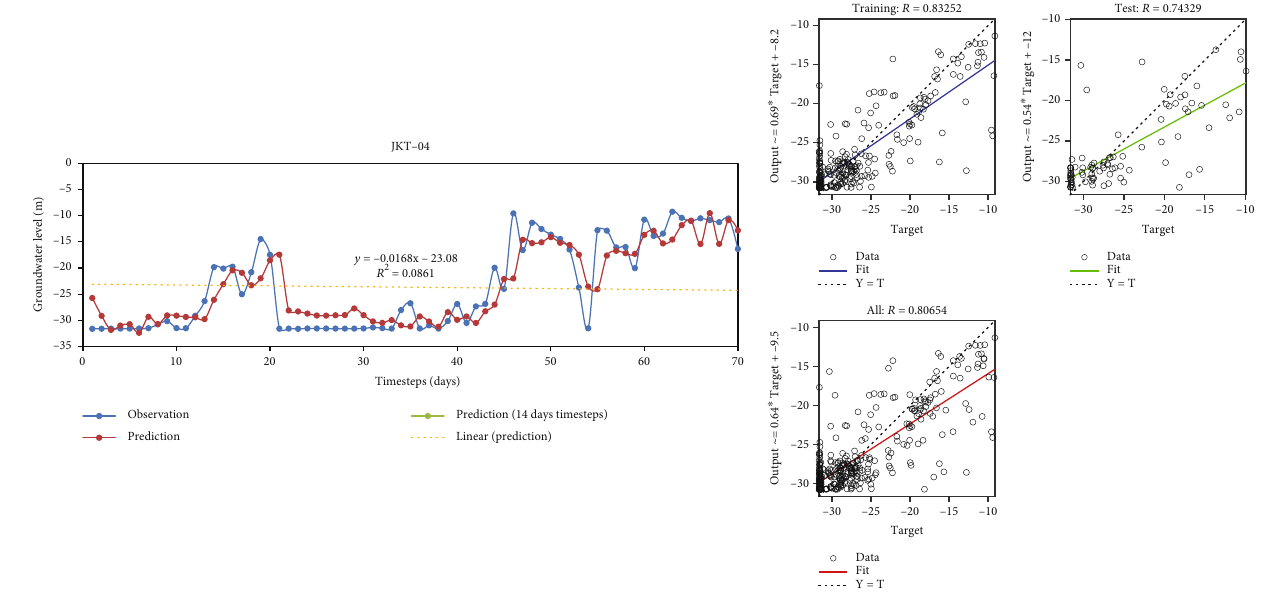
Figure 8: NARX prediction and model performance for